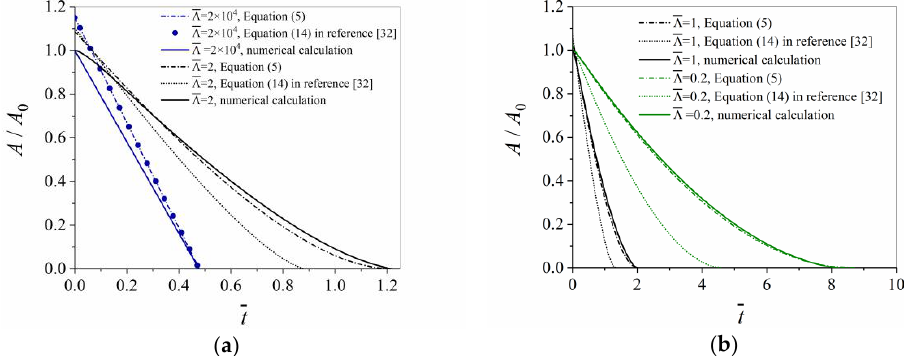
Figure 10. Dimensionless area plotted versus time t for different Λ -values. ( a ) Λ = 2 × 10 4 and Λ = 2,